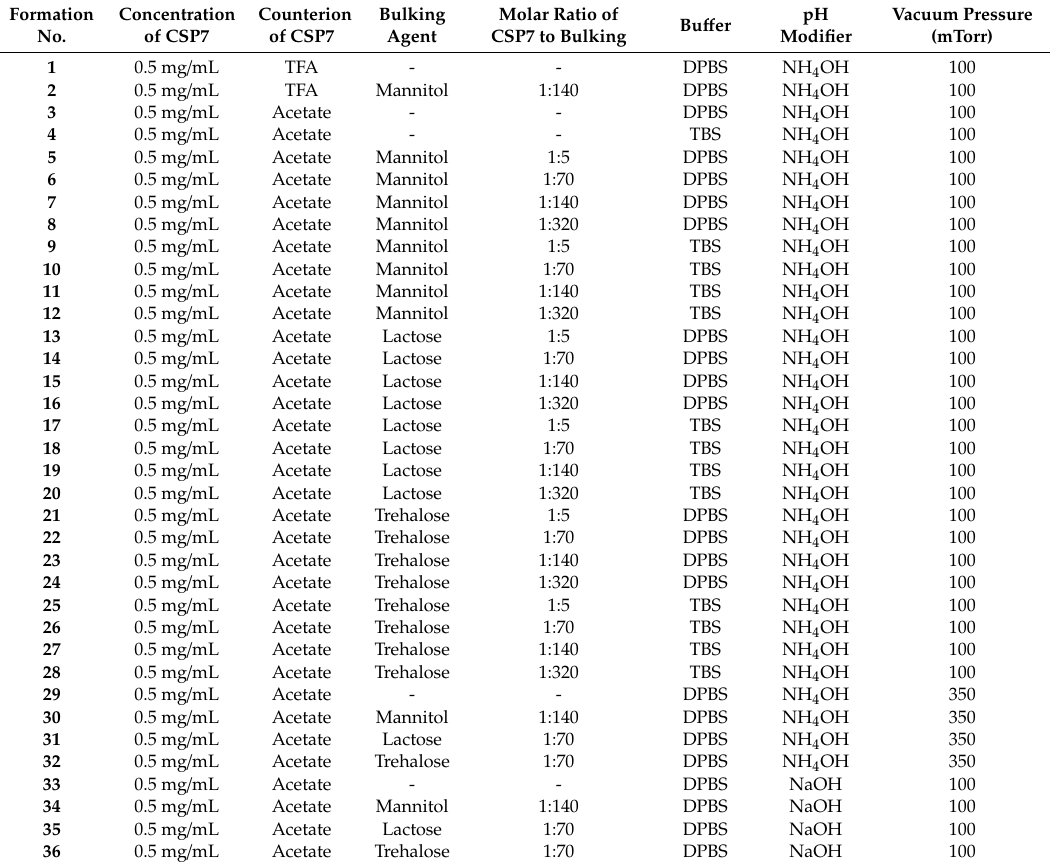
Table 1. Compositions of lyophilized formulations.